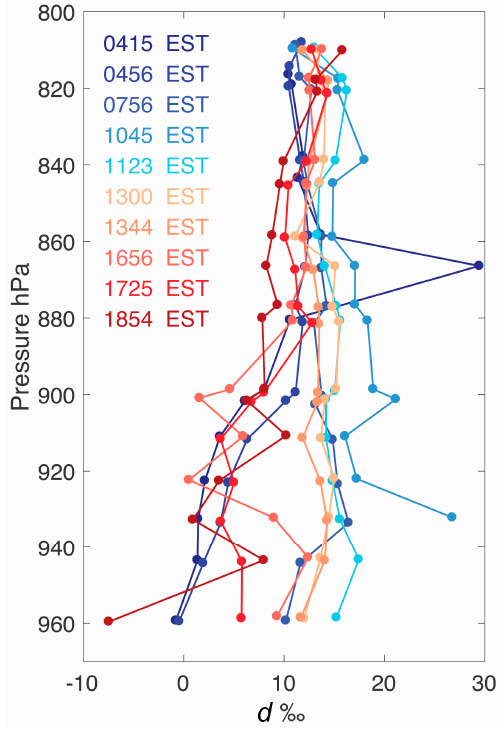
Figure 10. Vertical profiles of deuterium excess ( d ) constructed from isotope ratios of hydrogen ( δ D) and oxygen ( δ 18 O) sampled while driving an isotopic analyzer along the Auto Road on 19 August 2016. Profiles are color-coded by time. All times mark the start of the profile, which took 30–60 min to